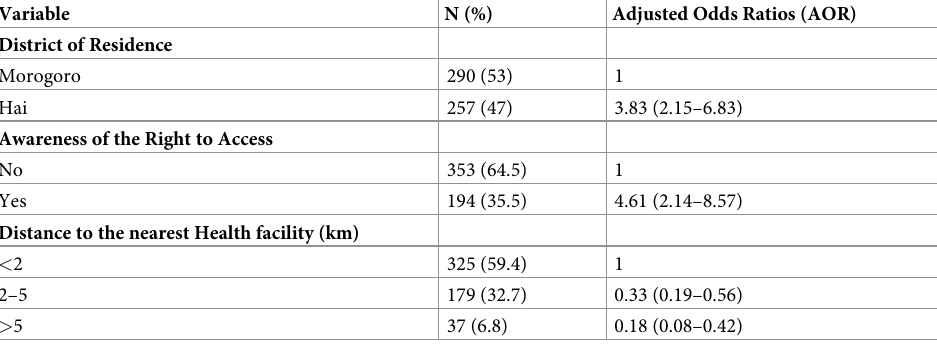
Table 5. Multivariate analysis results on factors associated with utilization of skilled birth